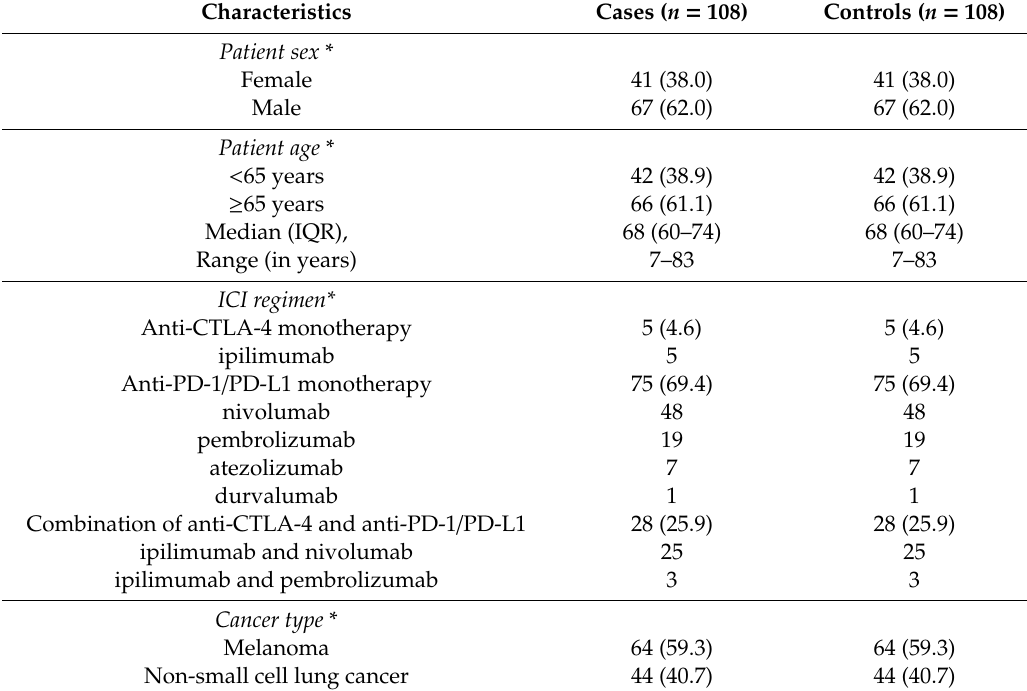
Table 1. Demographic and clinical characteristics of the study group of safety